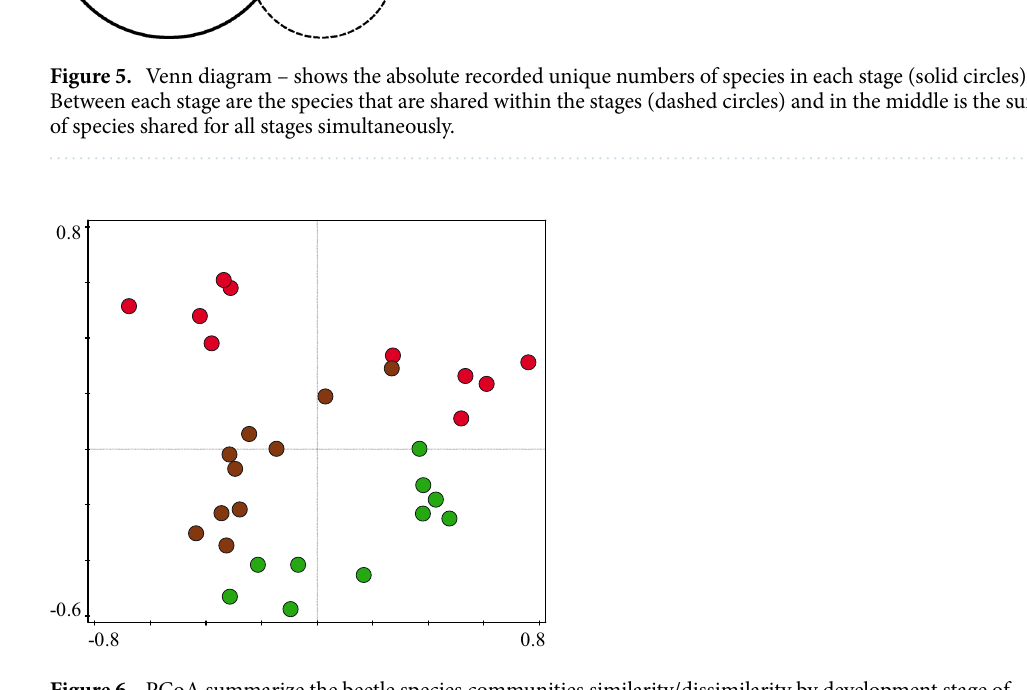
Figure 6. PCoA summarize the beetle species communities similarity/dissimilarity by development stage of beech stands. Red circle indicates optimum stage. Brown cicrle indicates disintegration stage and Green circle indicates growing up